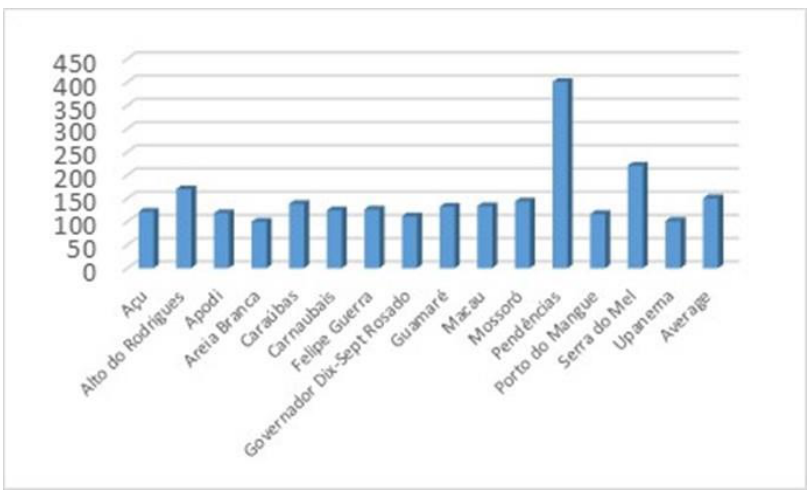
Figure 4. Average Royalties. Figure 4. Average